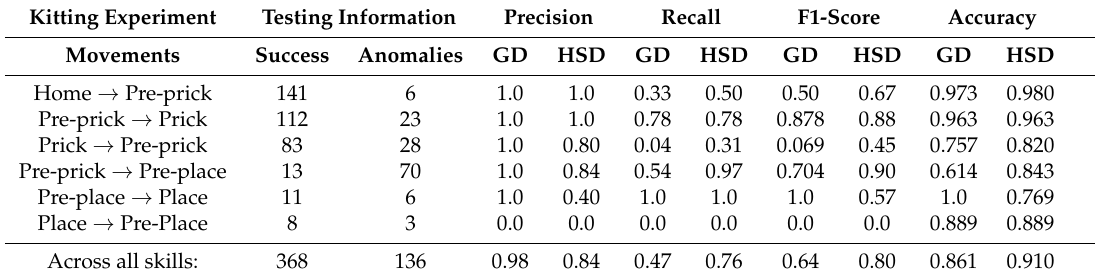
Figure 9. The comparison of two anomaly detectors for five robot anomalous executions. Each row represents the same testing execution. Left column: results of our hidden-state-based anomaly detector. Right column: results of the gradient-based anomaly detector [2]. The ground truth ( anomaly _ t _ by _ human ) is represented by green dashed lines and the detected anomalies are represented by yellow solid lines. Table 1. The comparison of anomaly detection performance measures between our proposed method and a baseline